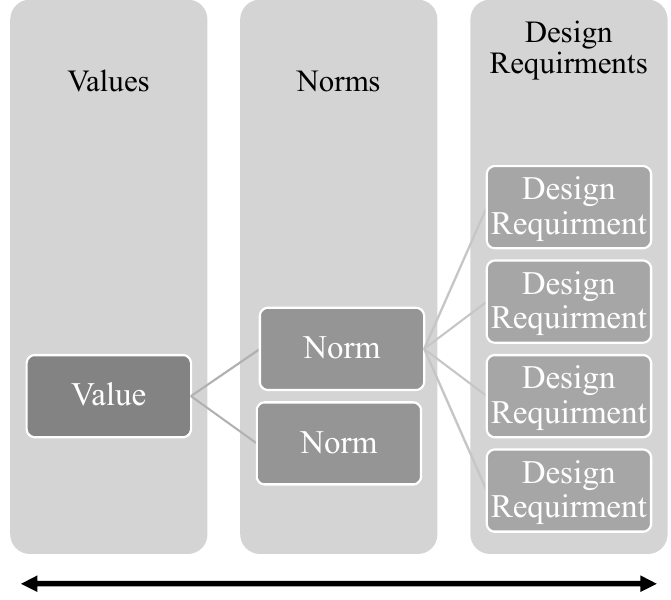
Figure 2. Bi-Directional Values Hierarchy.